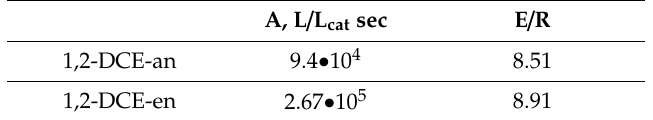
Table 14. Arrhenius parameters for hydrodechlorination of 1,2-dichloroethane and 1,2- dichloroethene